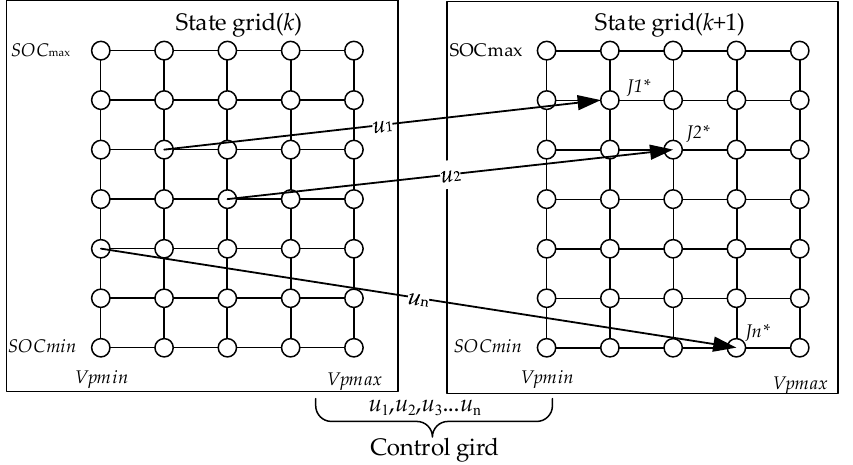
Figure 5. The calculation sketch of the MDDP.